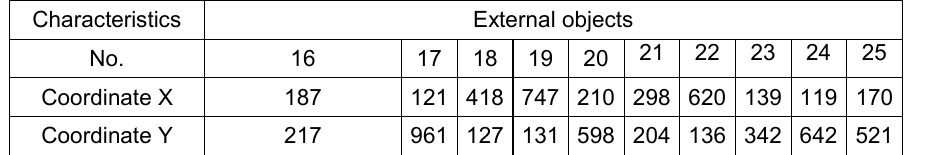
Table 2 – Characteristics of external objects (Dimitrijevi ć et al., 2013) Таблица 2 – Характеристики внешних объектов (Dimitrijevi ć et al., 2013)